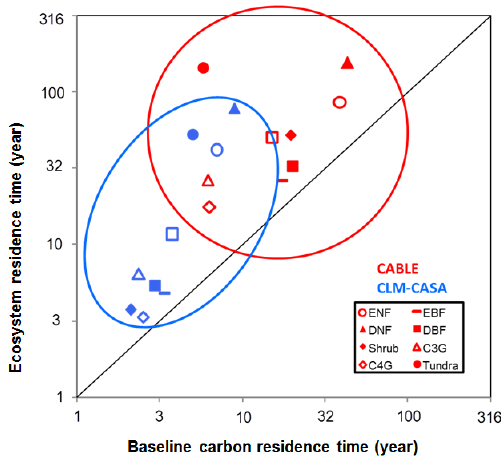
Figure 2. Spatial distribution of ecosystem residence time ( τ E ) and baseline carbon residence time ( τ (cid:48) ) (at global and biome level) E between CABLE and CLM-CASA (cid:48) . Abbreviations of biomes are given in Fig. 1. Circles separate the biomes of CLM-CASA (cid:48) and CABLE. Open squares in the circle show the global values.